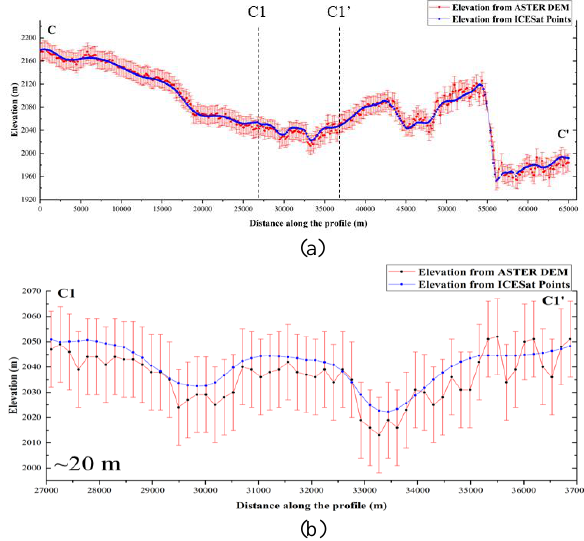
Figure 7. An example of comparison between ASTER DEM and ICESat profiles. (a) Terrain type: hill. (b) Partial details between point C1 and C1’ come from profile CC’. Both of the two error bars are 15